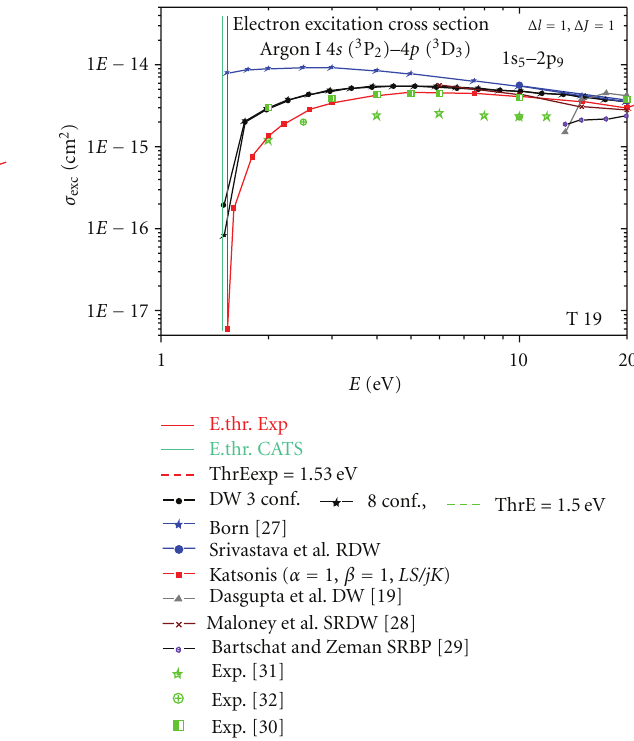
Figure 5: Electron excitation cross section of Ar I 4 s ( 3 P 2 )–4 p ( 3 D 3 ).